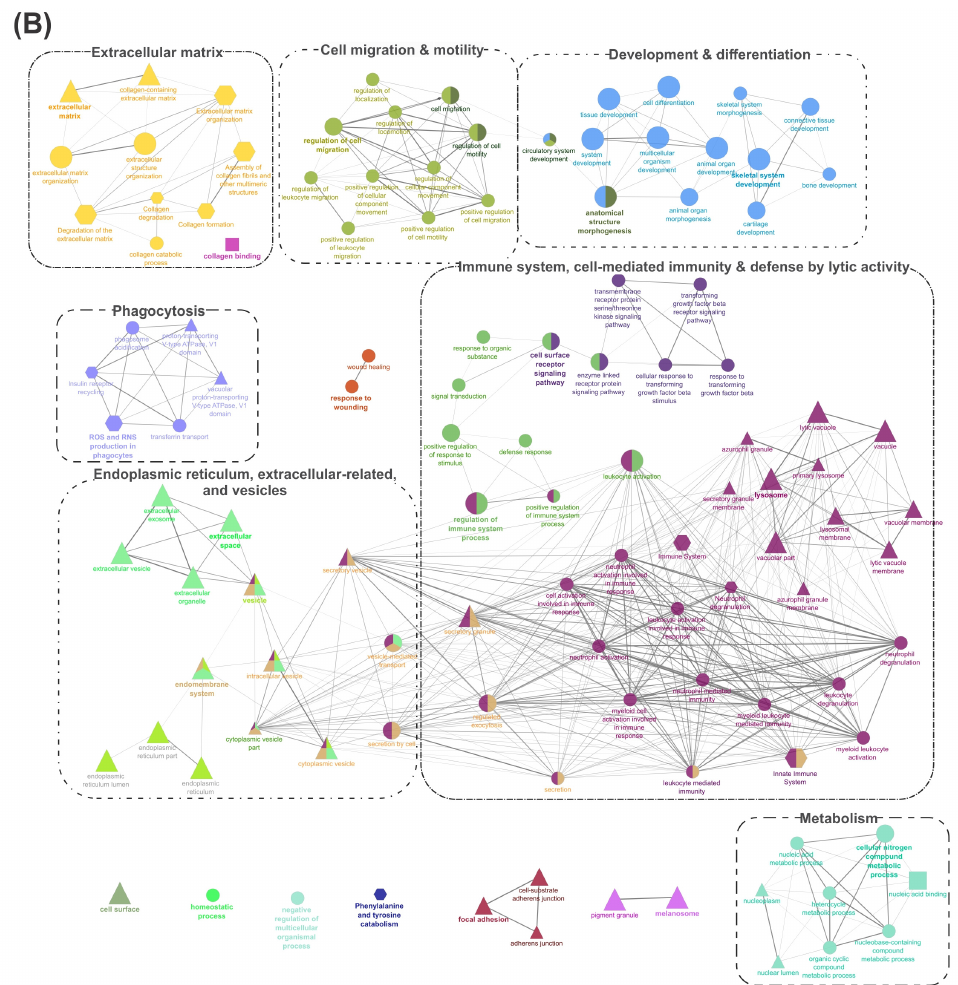
Figure 4. Gene-Ontology (GO) term enrichment and pathway term network analysis of DEGs shared by ADJ versus PRE and ATT versus PRE lists (1928 DEPs). ( A ) Upregulated DEGs (651 DEPs). ( B ) Downregulated DEGs (1277 DEPs). GO enrichment analysis was performed by the ClueGO [32] plugin in Cytoscape [33]. Two databases were used, including GO (BP, MF, and CC) and Reactome pathways for retrieving associated terms. Only the networks and pathways with p < 0.05 are illustrated. Functionally grouped networks with terms as nodes linked by edges based on their kappa score level ( ≥ 0.4) are shown. Related-GO terms are grouped and illustrated with distinct color and labeled with the same color. The node size represents the significance of term enrichment. Functionally related groups partially overlap. When a particular GO term is shared by two or more di ff erent GO cluster groups, the node is shown by multiple colors. The shape of the nodes indicates the source of the database from where a term was retrieved (ellipse, GO_BP; rectangle, GO_MF; triangle, GO_CC; Reactome, hexagon). The thickness of edges indicates the kappa score (strength of intra-connectivity between cluster groups). Related clusters are shown together within a dotted border and labeled with broad themes for discussion purposes. Refer to the Supplementary Files S7 and S8 for details and high-resolution